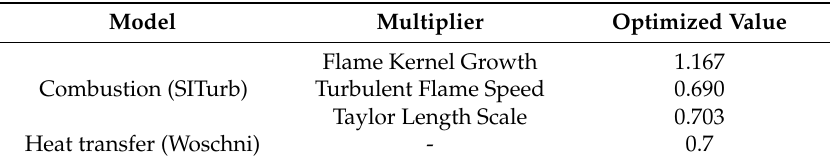
Table 4. Multipliers for optimization.